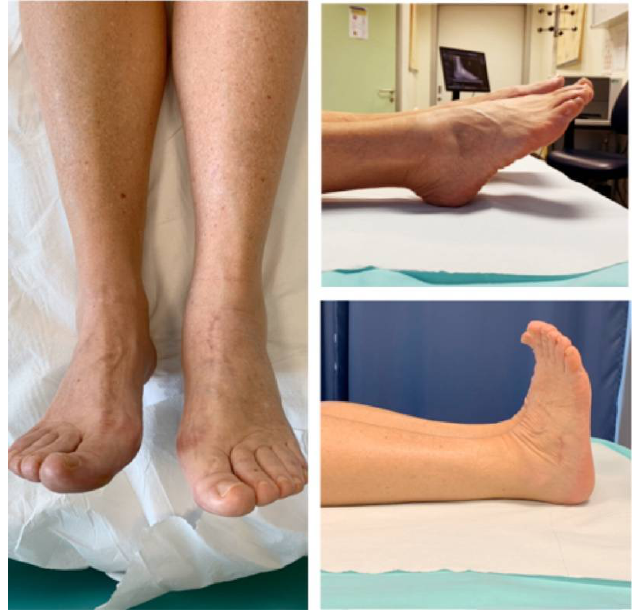
Figure 5. Follow-up after 4 months.